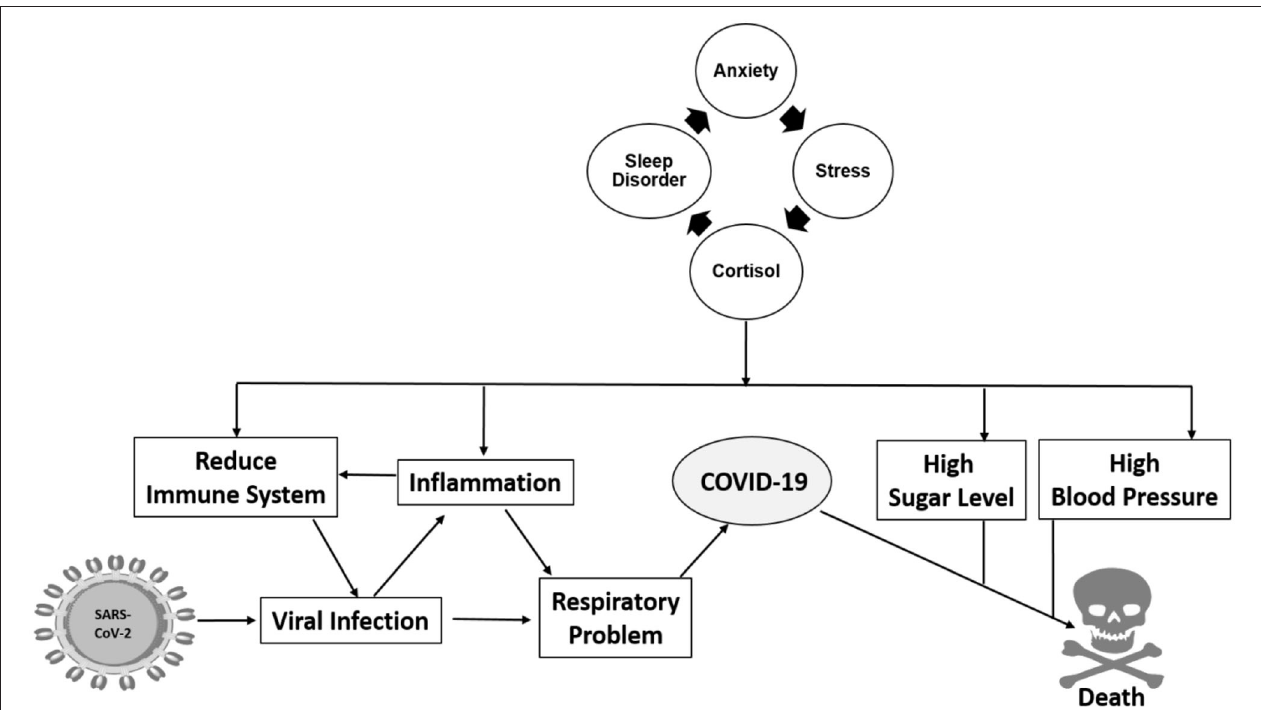
FIGURE 2 | Sleep disorder is intrinsically related to anxiety which increases the possibility of viral infection through multiple pathways of inflammation, hypertension, high sugar levels, and